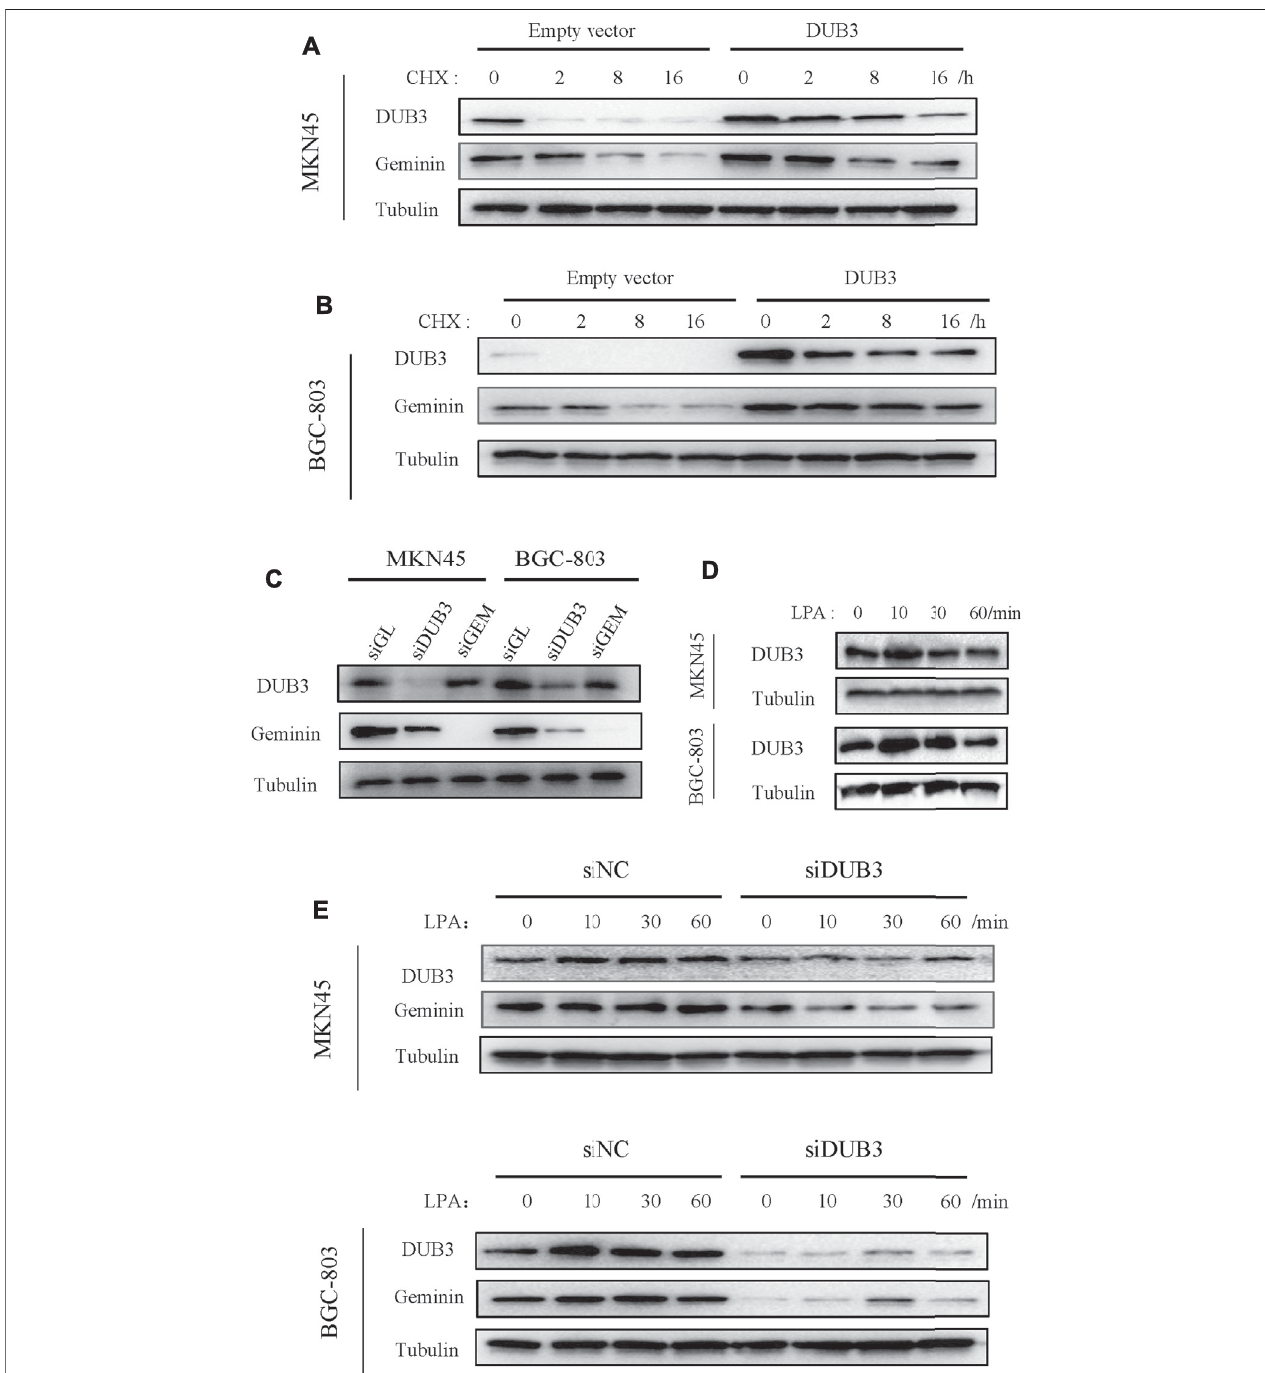
FIGURE4 | LPA potentiates geminin stability through DUB3 in gastric cancer cells. (A, B) Gastric cancer cells MKN45 (A) and BGC-803 (B) were transfected with the indicated vectors (empty vector; DUB3, a vector that contains Homo sapiens ubiquitin-speci fi c peptidase 17-like family member 2 [USP17L2] mRNA [DUB3]), and incubatedwithcycloheximide(CHX,50 µg/ml)fortheindicatedtimepoints.Westernblottinganalysiswiththeindicatedantibodies. (C) Twogastriccancercells(MKN45 and BGC-803) were transfected with the indicated siRNA. Cell lysates were analyzed by Western blotting. (D) Two gastric cancer cells were treated with LPA time gradient, and cell lysates were analyzed by Western blotting. (E) Two gastric cancer cells (MKN45 and BGC-803) were transfected with the indicated siRNA, together with LPA time gradient treatment, and cell lysates were analyzed by Western blotting.